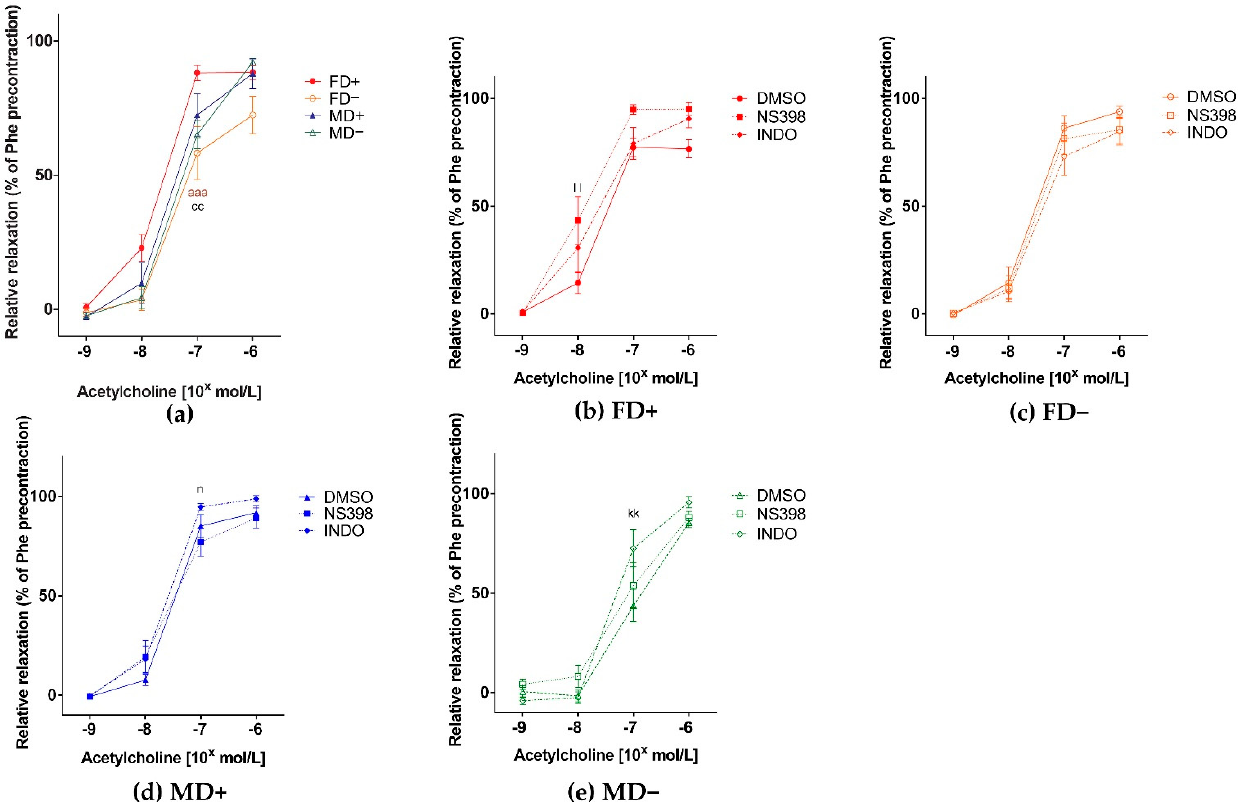
Figure 2. Relaxation ability of renal arteries: ( a ) Acetylcholine-induced relaxation of isolated renal artery segments. Significantly reduced relaxation was observed in FD– and MD– group compared to the FD+ group at 10 − 7 mol/L Ach concentration. Data are shown as mean ± SEM; N = 8 in each group; aaa : p < 0.001 FD+ vs. FD–; cc: p < 0.01 FD+ vs. MD–; Ach-induced relaxation in the presence of COX-2 inhibitor (NS398) or general COX inhibitor (indomethacin; INDO), or their vehicle DMSO ( b ) in female Vitamin D supplemented rats. Specific COX-2 inhibition resulted in increased relaxation in FD+ experimental group; ( c ) in female Vitamin D deficient rats. There was no significant difference